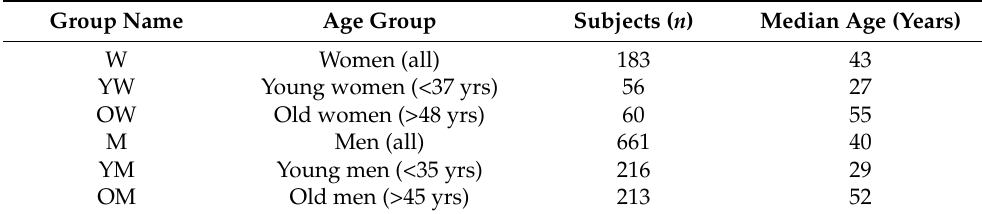
Table 1. Age characteristics of the healthy blood donor volunteers in this study. Women (W) and men (M) were stratified into young and old women (YW, OW) and young and old men (YM, OM) by taking the lower 33% and upper 67% percentiles of the age distribution among women and men (cfr. with Table 1 and Figure 1 from [17]). The term “old” is used here as a placeholder given the relatively young age of the study population.